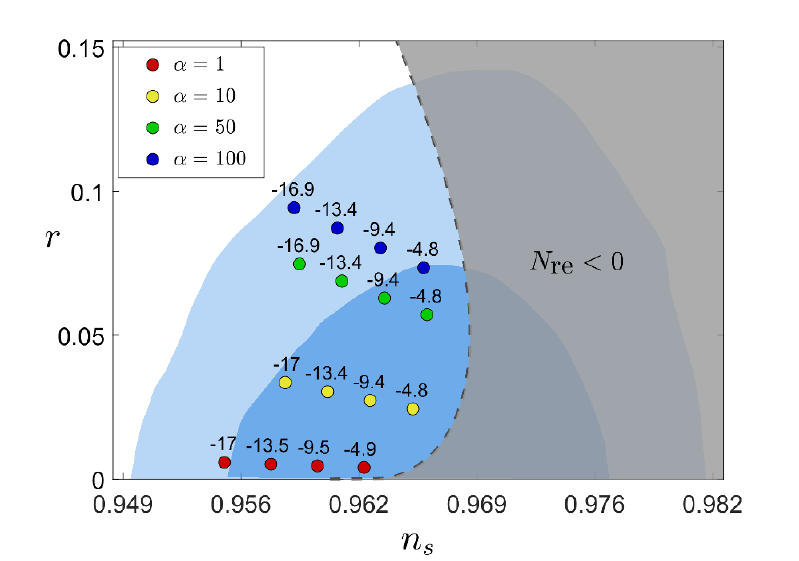
Figure 6. The e(cid:11)ect that the reheating phase has on the predictions of (cid:11) -attractor E-models with n = 1 for CMB is illustrated in the n s - r plane for a set of sample points. We assume that reheating is primarily driven by an interaction of the form g(cid:30)(cid:31) 2 . The predictions for n s and r are indicated by the disks of a given colour for (cid:12)xed (cid:11) , but with di(cid:11)erent values of g . The numbers over disks are the logarithmic values of the coupling log ( g=m (cid:30) ) computed using eq. (3.9). The sky blue and 10 light blue areas display marginalized joint con(cid:12)dence contours for ( n s ; r ) at the 1 (cid:27) (68%) and 2 (cid:27) (95%) CL [5], respectively. The dashed line corresponds to N re = 0, so that N re < 0 in the shaded region. The BBN constraint T re > 10 MeV is respected on all chosen points in the